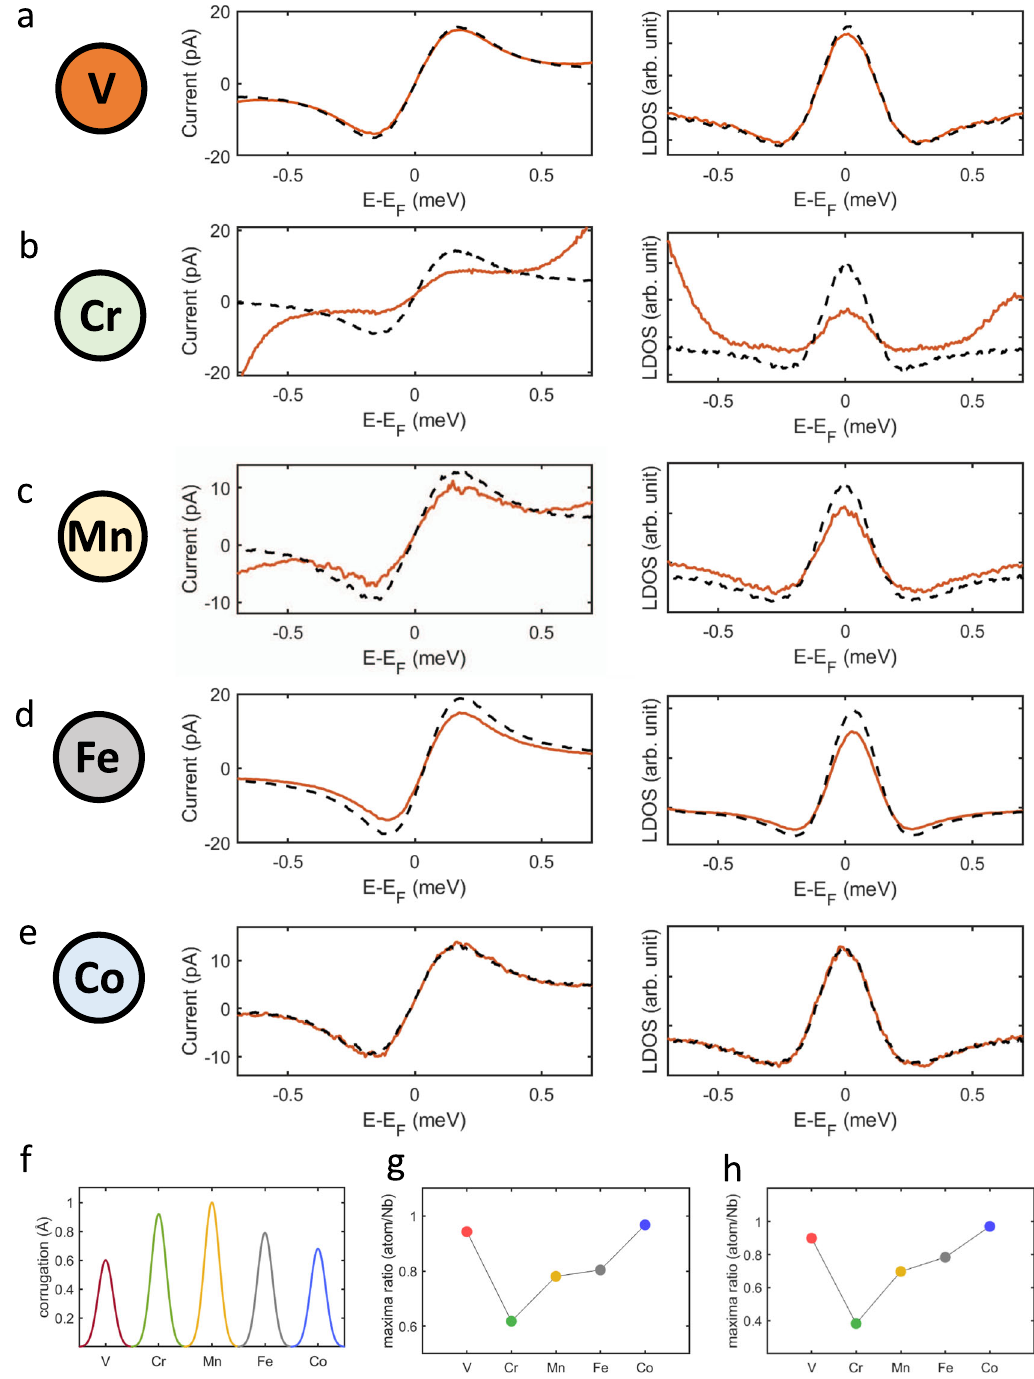
Fig. 3 Scanning Josephson spectroscopy. a – e I − V characteristics (left panels) and respective d I /d U signals (right panels) for all elements. f Apparent heights of the adatoms. g , h Reduction induced by the different magnetic perturbations in the maximum Cooper pairs current I max and intensity of the d I / d U peak, respectively, both showing the same trend. Stabilization parameters: V = 5 meV, I = 15